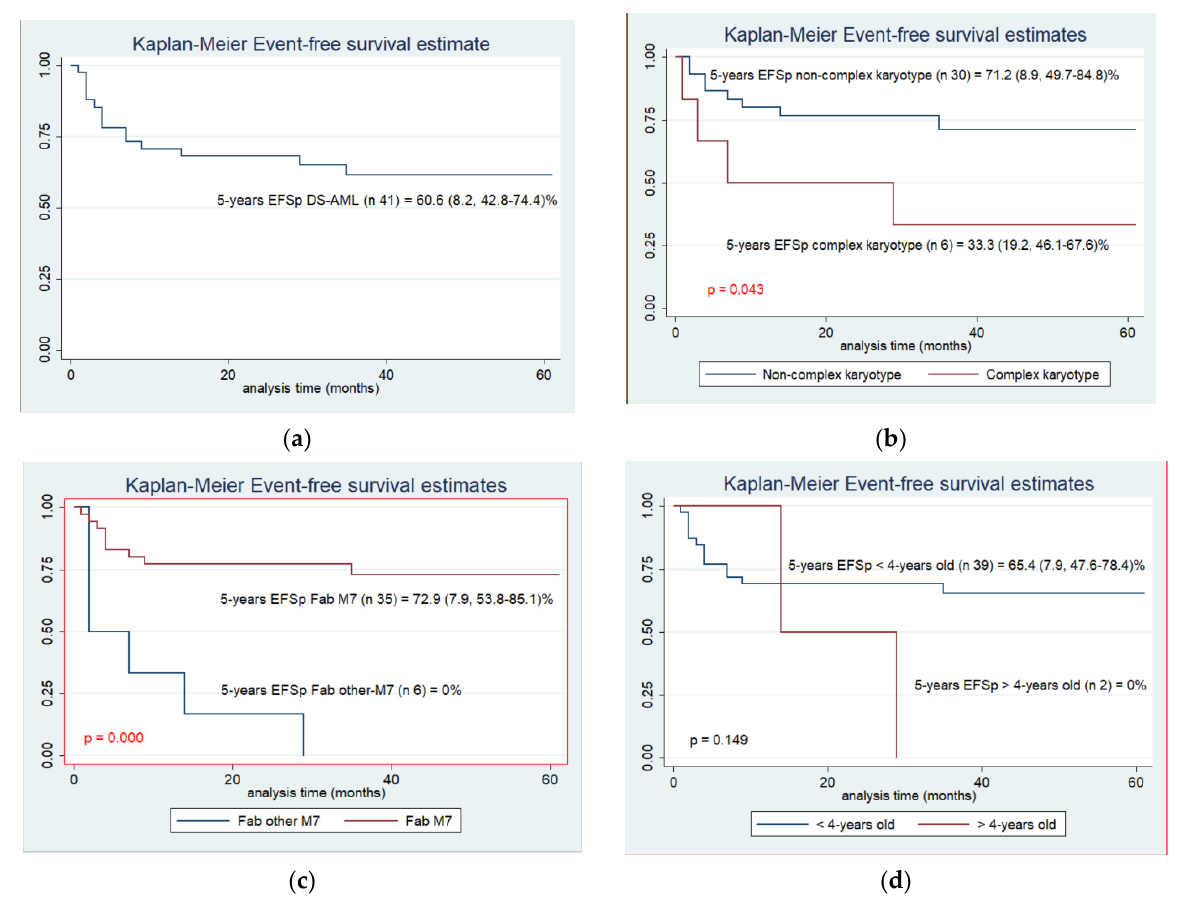
(Figure 2). In the cox regression model, CK, immunophenotype and age were considered. The Fab M7 immunophenotype (classic ML-DS) was the strongest prognostic factor in univariate and multivariate analysis ( p = 0.000) (Table 2).